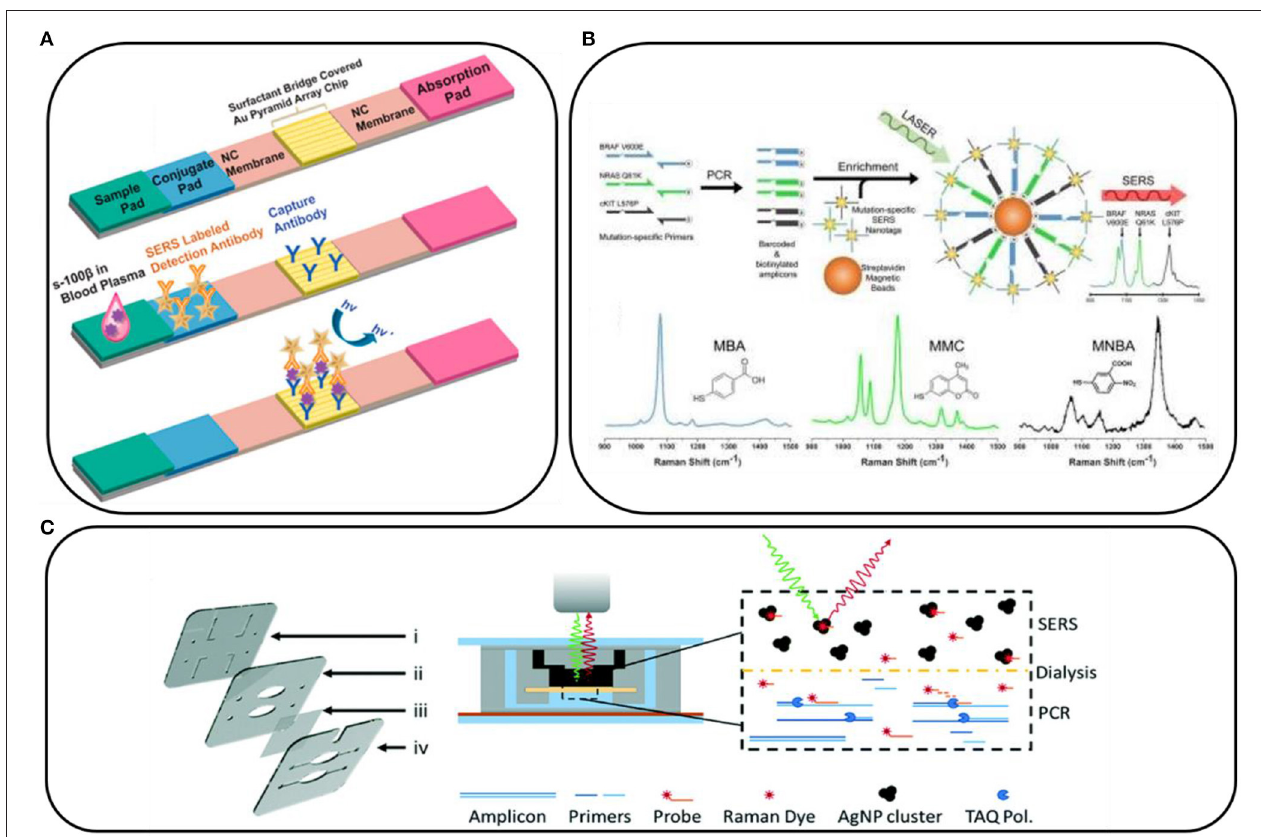
FIGURE 2 | (A) Schematic illustration of a paper-based lateral flow strip. Reprinted with permission from Gao et al. (2021b). Copyright (2021) American Chemical Society; (B) Conceptual schematic of the multiplex PCR/surface-enhanced Raman spectroscopy (SERS) assay and SERS nanotags with the examples of Raman reporter molecules. Reprinted with permission from Wee et al. (2016). Copyright (2016) Ivyspring International Publisher; (C) Scheme of dialysis-driven PCR–SERS device. Reprinted with permission from Restaino and White